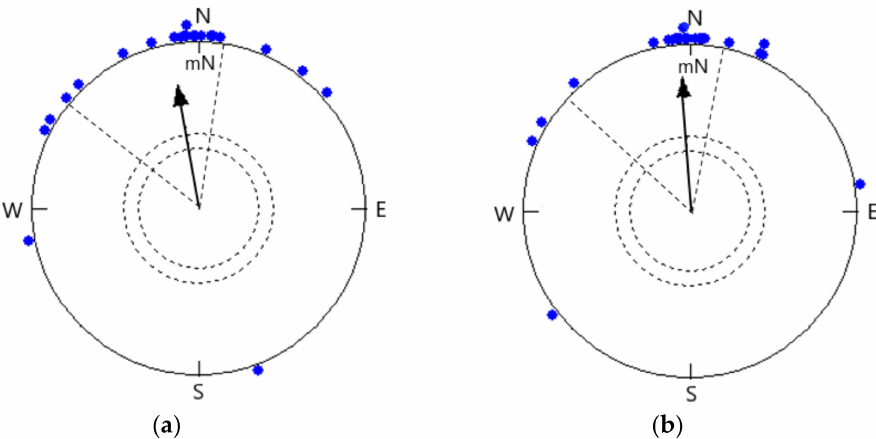
Figure 2. Orientation of Red-headed Buntings under simulated overcast conditions at ( a ) 22 ◦ C temperature ( α = 350 ◦ , n = 22, r = 0.758, p < 0.0001; 95% CI = 332 ◦ –8 ◦ ) and ( b ) 38 ◦ C temperature ( α = 356 ◦ , n = 22 (the same birds were tested at 22 ◦ C), r = 0.814, p < 0.0001; 95% CI = 341 ◦ –11 ◦ ). Each symbol (filled dot) on the circumference of the circle depicts the mean heading of an individual bird tested 3